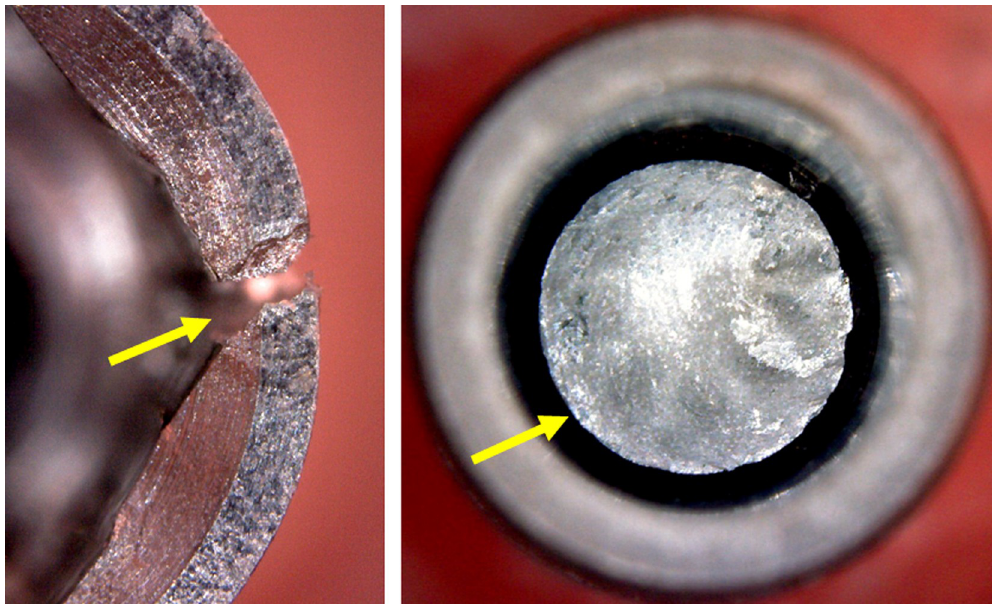
Fig 9. Representative images of the maximum torque applied in the implants: (a) image of an implant sample with hexagonal connection (IH3 group) showing a complete fracture of the implant wall (yellow arrow); (b) image of a sample of Morse taper connection (MT3 group) showing the fracture of the insertion driver inside the implant (yellow